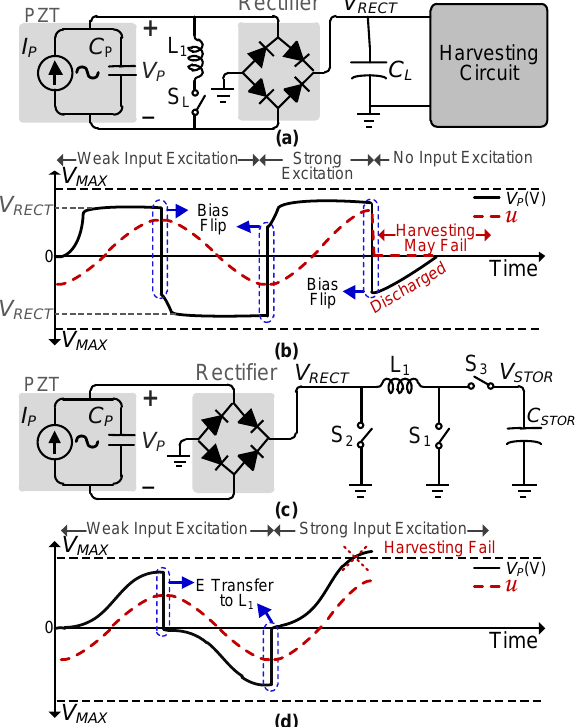
Figure 1. ( a ) SSHI-based harvesting interface circuit, ( b ) its operation waveform with different input excitations, ( c ) SECE-based harvesting interface circuit, and ( d ) its operation waveform with different input excitation strengths.